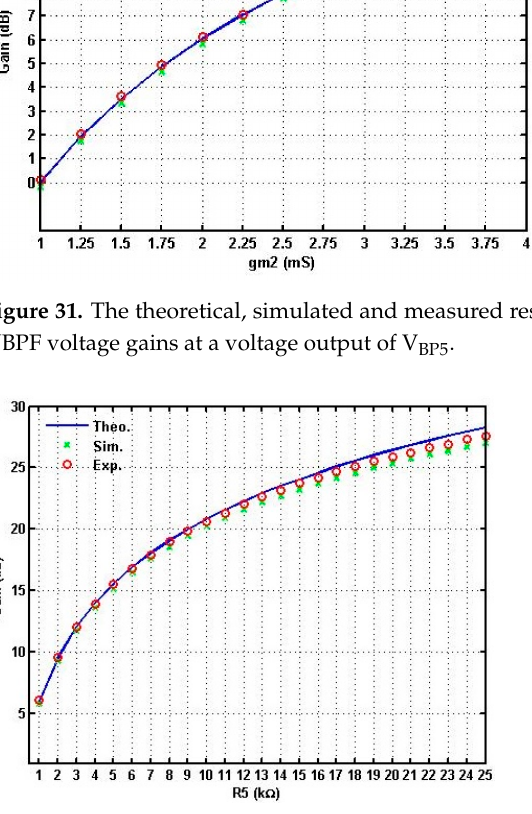
Figure 32. The theoretical, simulated and measured results of the independent amplitude adjustable NBPF voltage gains at a voltage output of V BP6 .